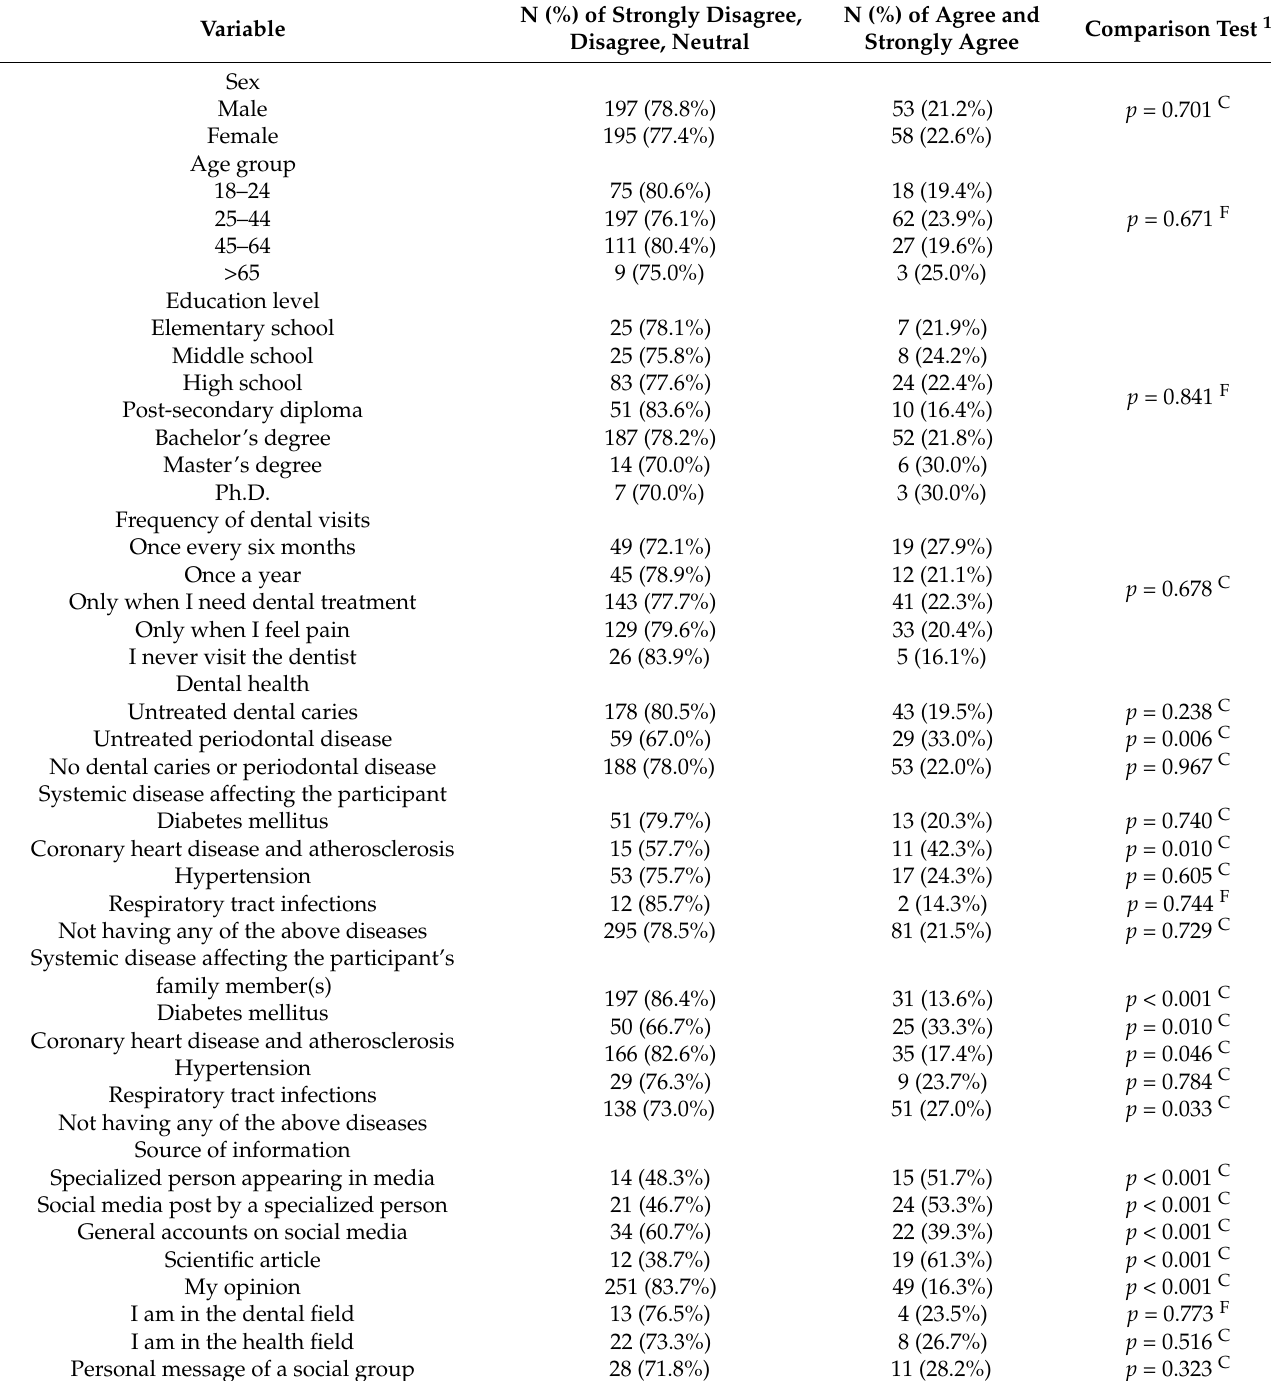
Table 9. Awareness about the association between periodontal disease and coronary heart disease and atherosclerosis distributed by various